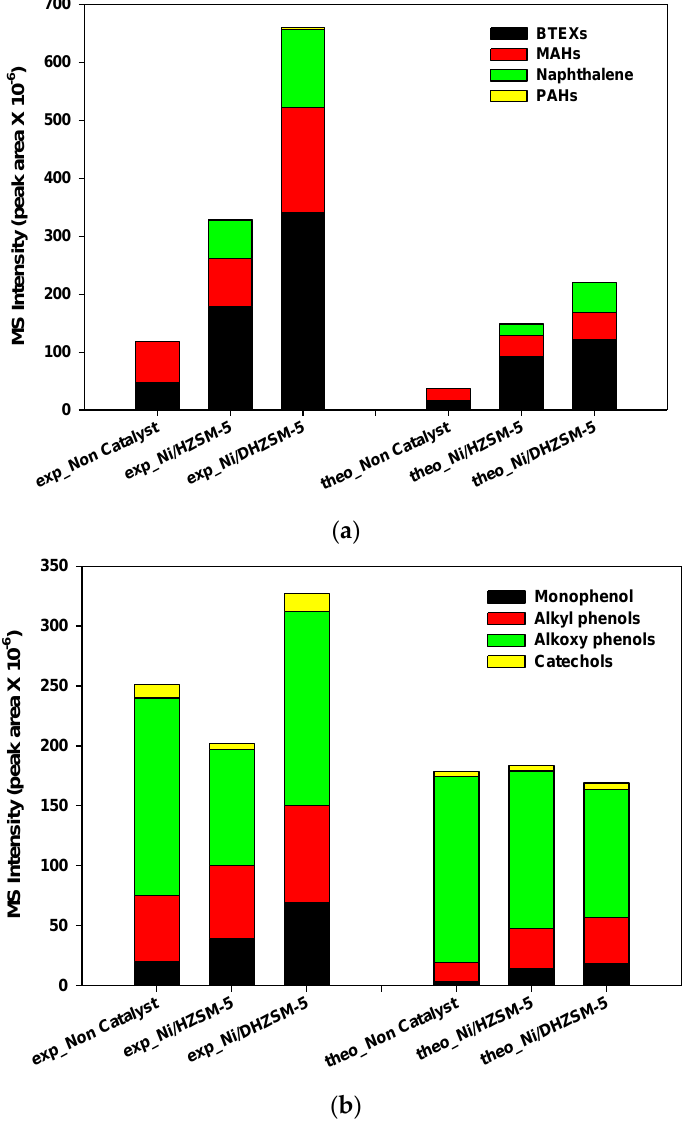
Figure 7. Comparison of experimental and theoretical value of ( a ) aromatic hydrocarbons and ( b ) phenolics.